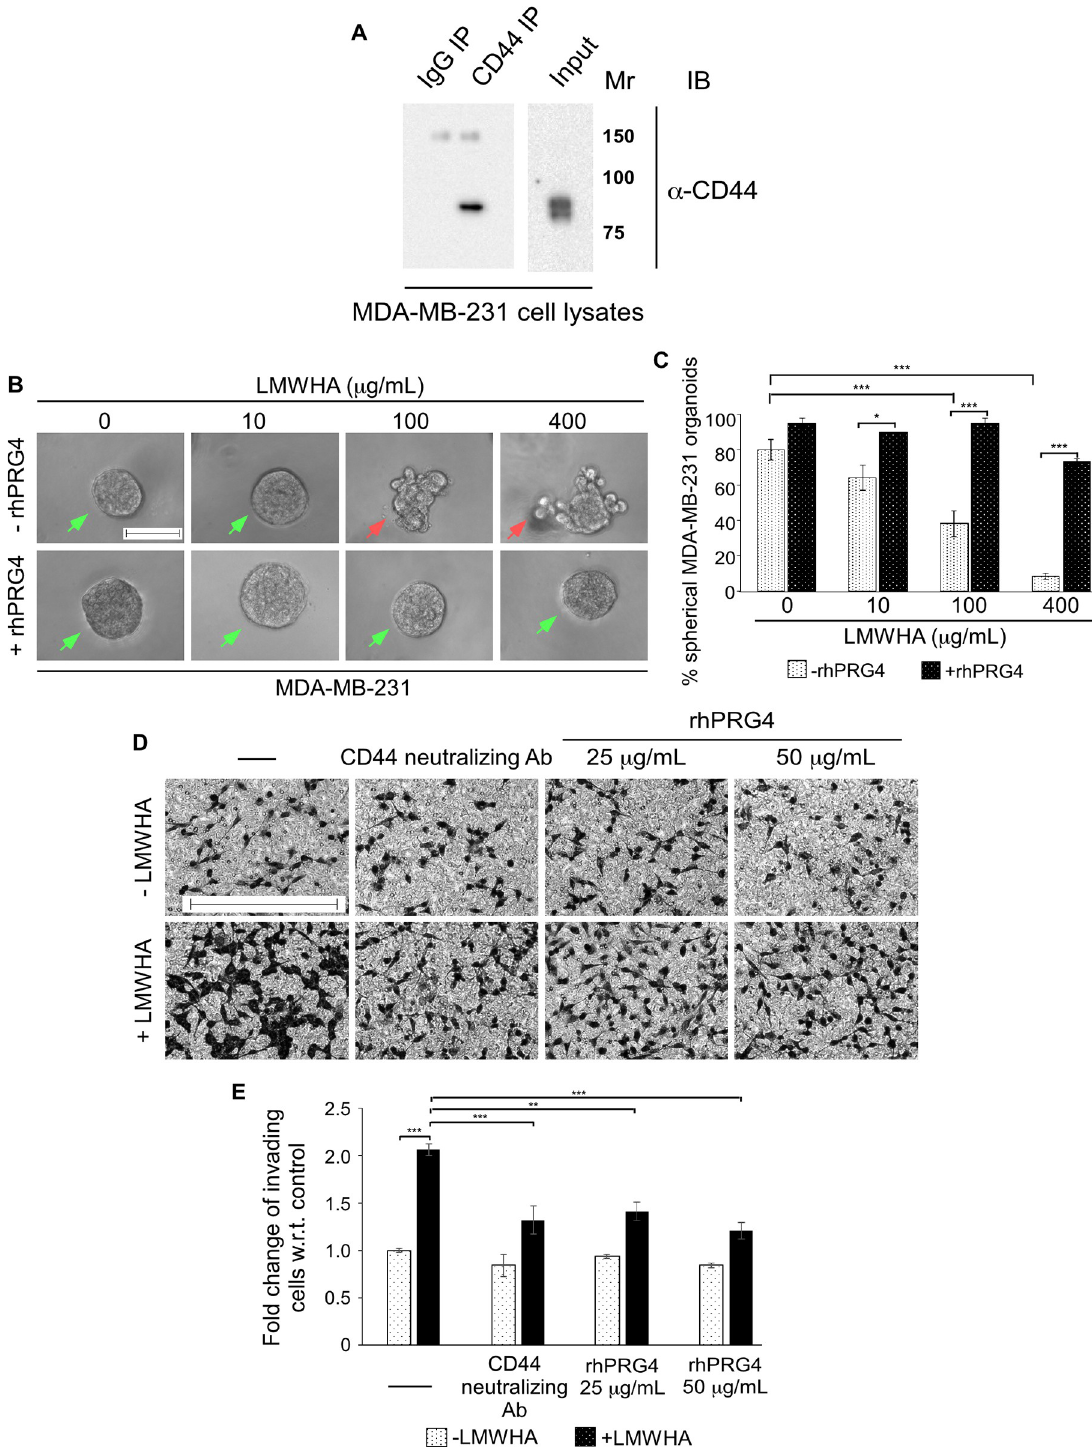
Fig 4. rhPRG4 suppresses low molecular weight hyaluronic acid (LMWHA)-induced invasion of breast cancer cells. (A) Lysates of MDA-MB-231 cells were subjected to immunoprecipitation using a rat CD44 antibody (CD44 IP) or a non-specific rat IgG antibody (IgG IP) followed by CD44 immunoblotting of the immunoprecipitates. CD44 protein abundance in the lysates was also confirmed by CD44 immunoblotting (input). Mr indicates Markers’ molecular size. (B) Representative DIC light microscopy images of 8-day old